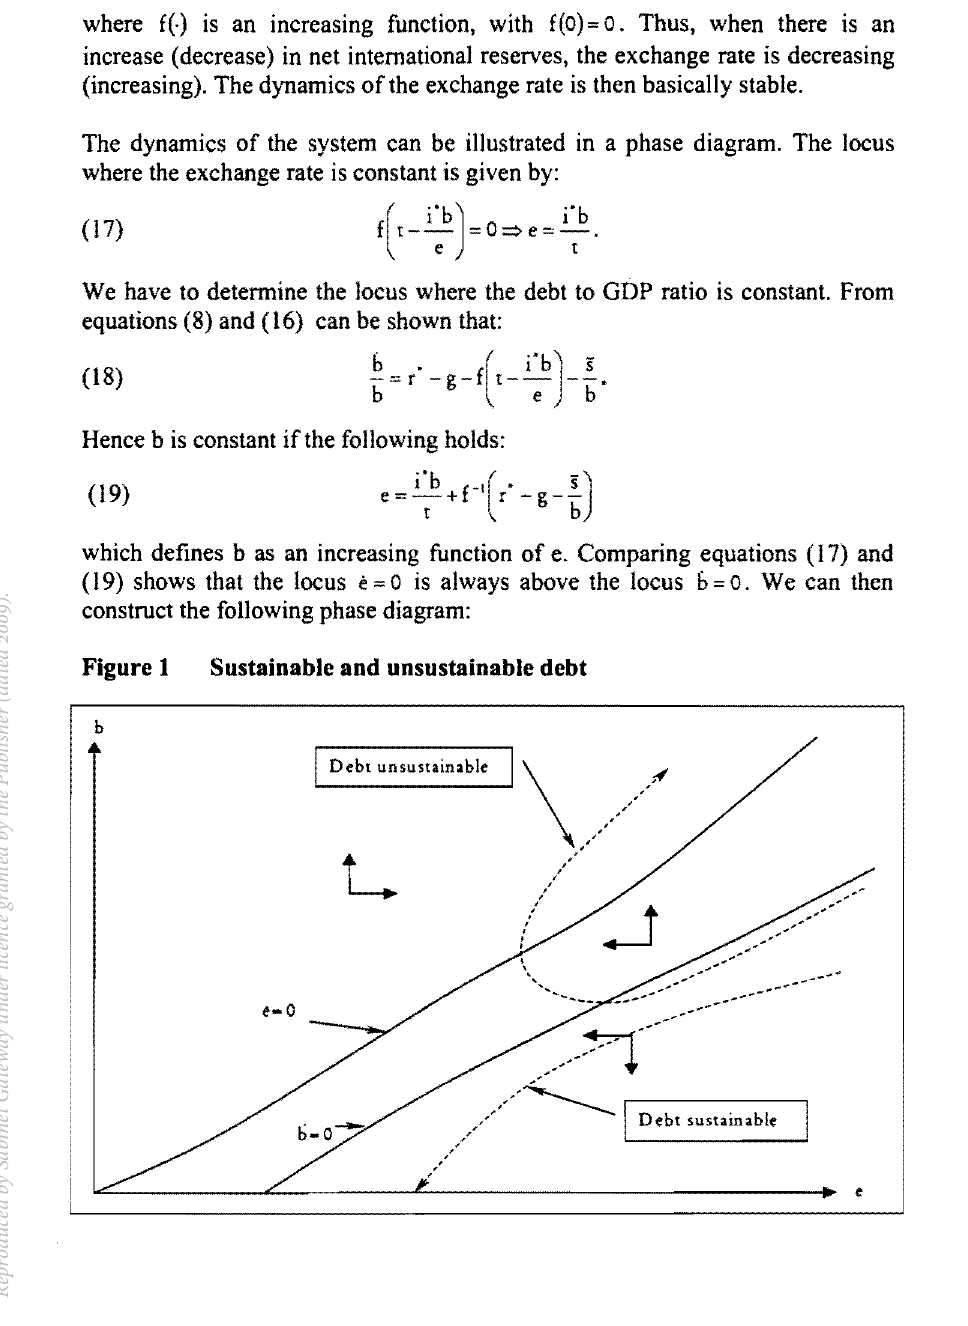
Sustainable and unsustainable